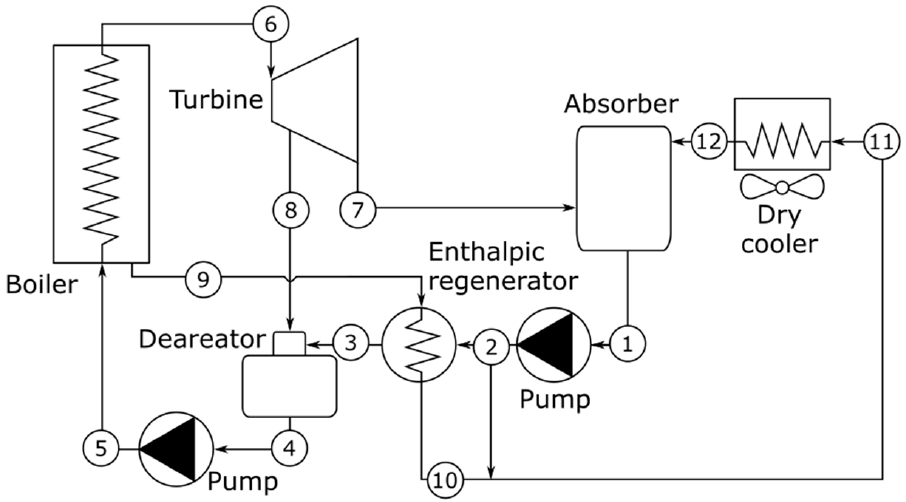
Figure 20. Equipment of the Hygroscopic cycle (adapted from [75]).